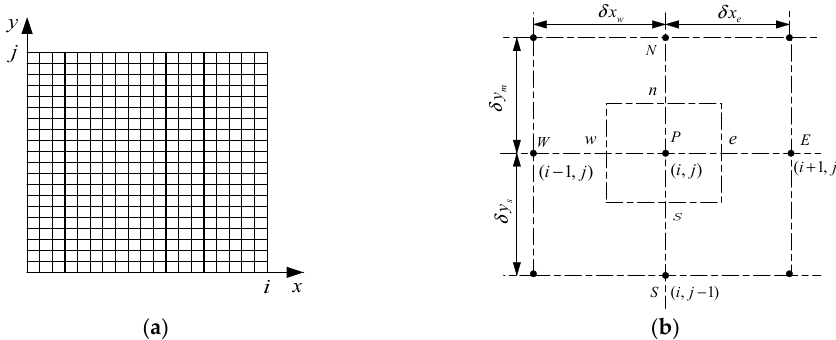
Figure 5. ( a ) Schematic diagram of oil film plane mesh generation; ( b ) control volume structure diagram.